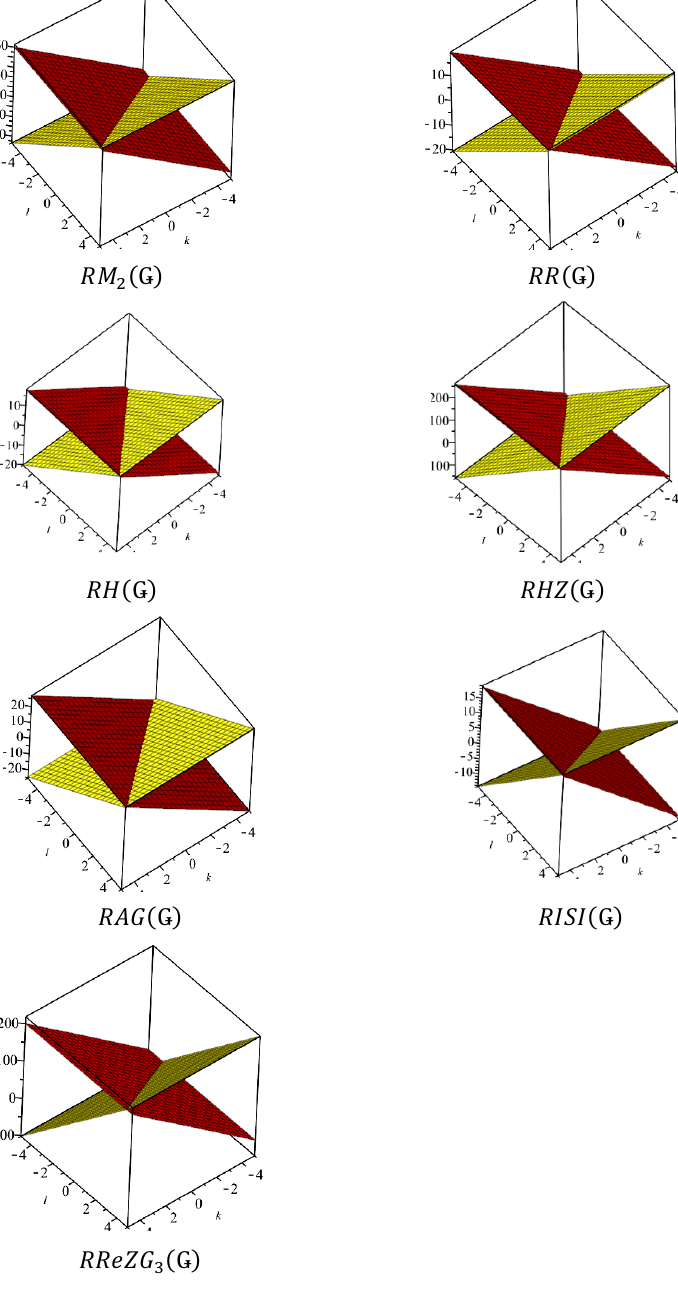
(Ǥ) , ((cid:3291),(cid:3292))